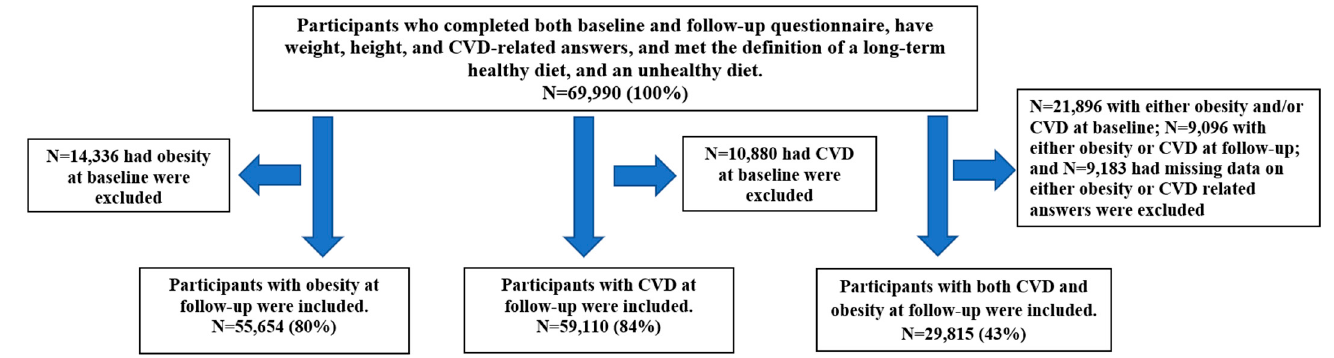
Figure 2. Flow chart of numbers of participants with data on obesity and CVD.